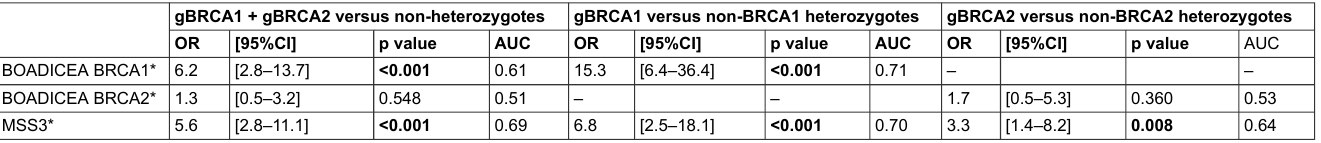
Table S3: Performance of BOADICEA and MSS3 scores (AUC) according to mutational status. gBRCA1 + gBRCA2 versus non-heterozygotes gBRCA1 versus non-BRCA1 heterozygotes gBRCA2 versus non-BRCA2 heterozygotes OR [95%CI] p value AUC OR [95%CI] p value AUC OR [95%CI] p value AUC BOADICEA BRCA1* 6.2 [2.8–13.7] <0.001 0.61 15.3 [6.4–36.4] <0.001 0.71 – – BOADICEA BRCA2* 1.3 – –